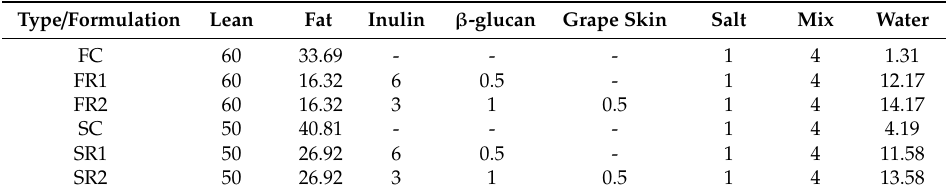
Figure 1. Frankfurt and Spanish sausage and formulations. C: control regular fat content; R1: fat reduced with inulin + β -glucan; R2: fat reduced with inulin + β -glucan + grape skin. Table 1. Frankfurt and Spanish sausage formulations ( w:w , %).